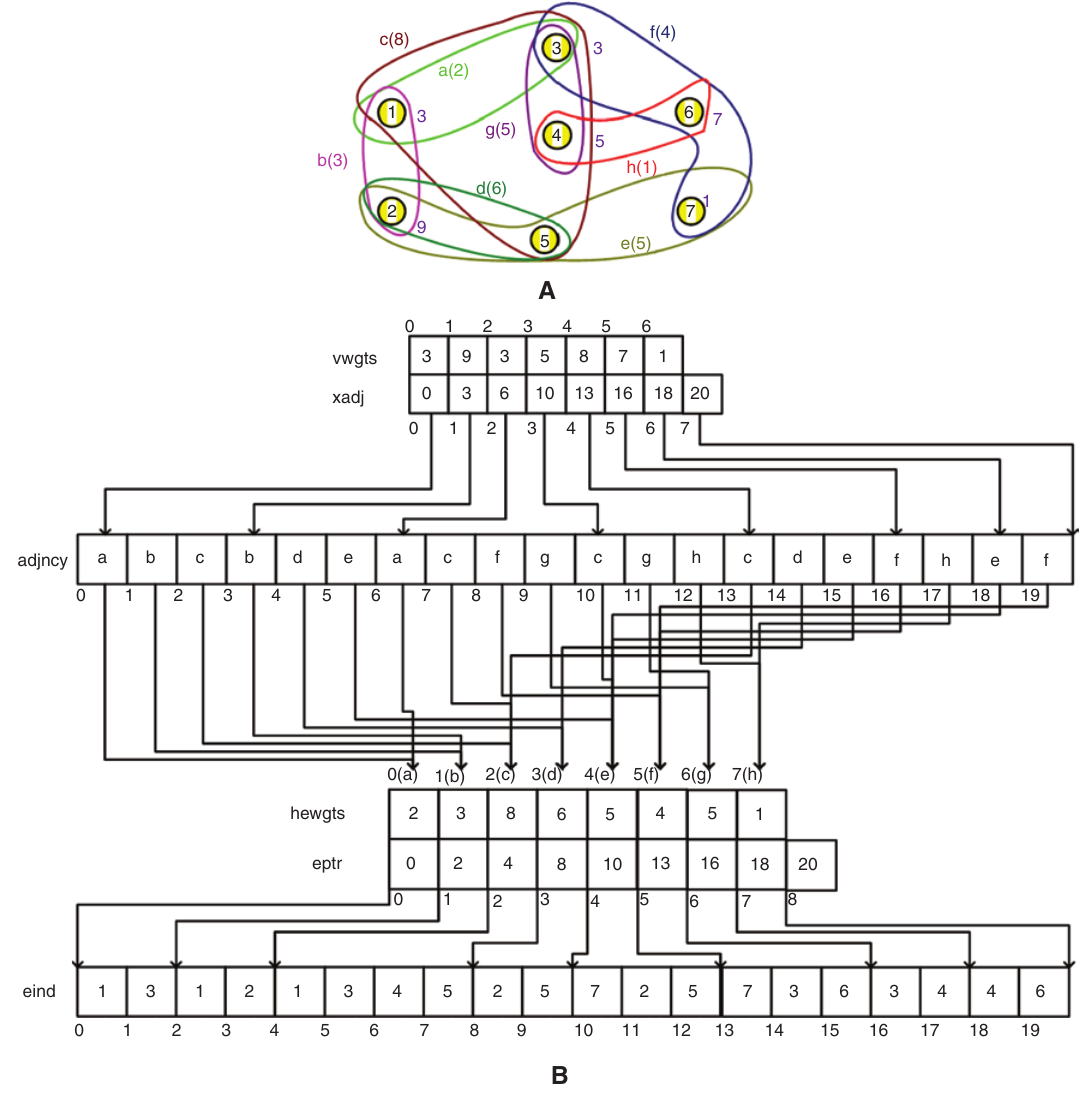
Figure 2: An Example of Weighted Hypergraph and its Improved Compressed Storage